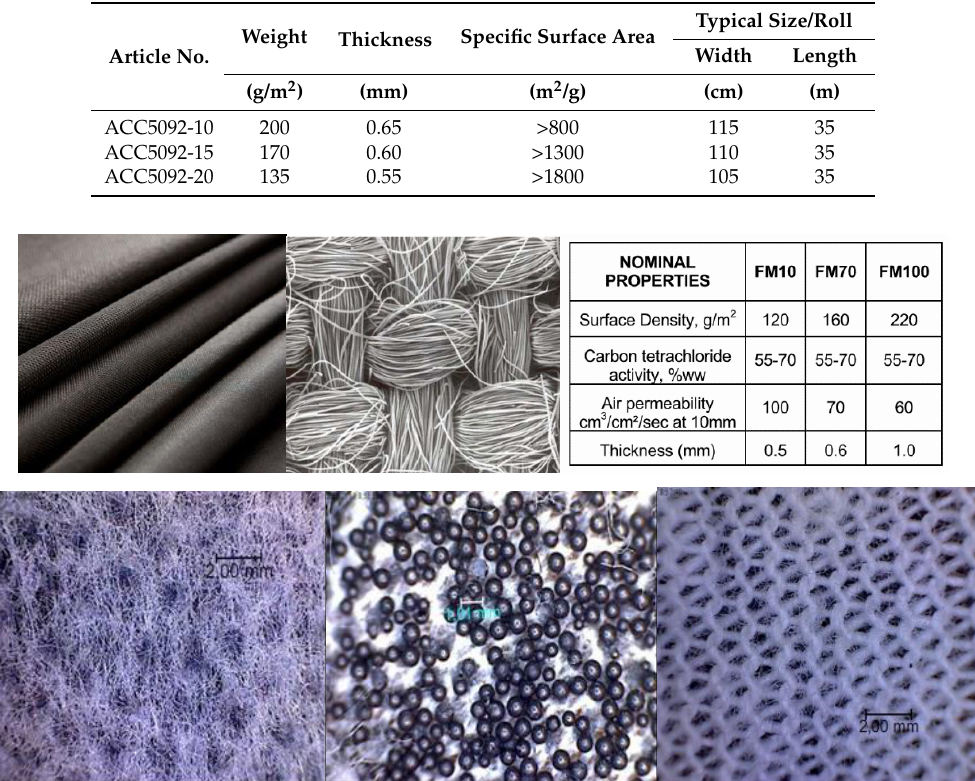
Figure 6. Chemviron Carbon ZORFLEX FM10, 100% woven activated carbon cloths from activated fibers.